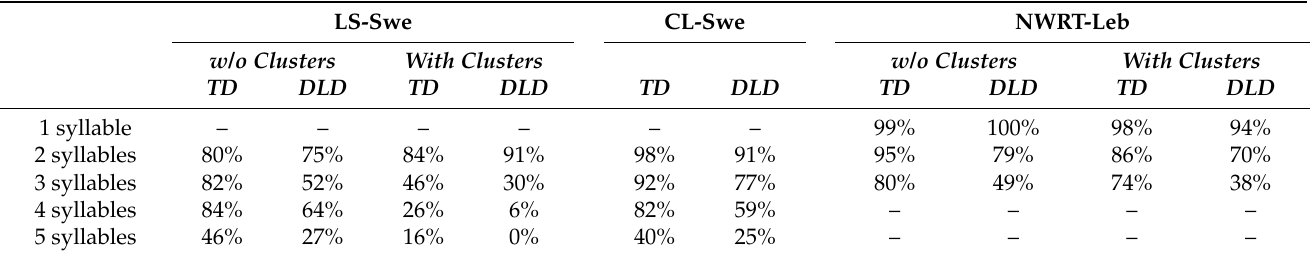
Table 12. Accuracy (% correct answers) for NWR tasks by number of syllables and presence of clusters for the 5–7-year-olds in the TD sample (N = 77) and the children in the DLD sample (N = 11). LS-Swe CL-Swe NWRT-Leb w/o Clusters With Clusters w/o Clusters With